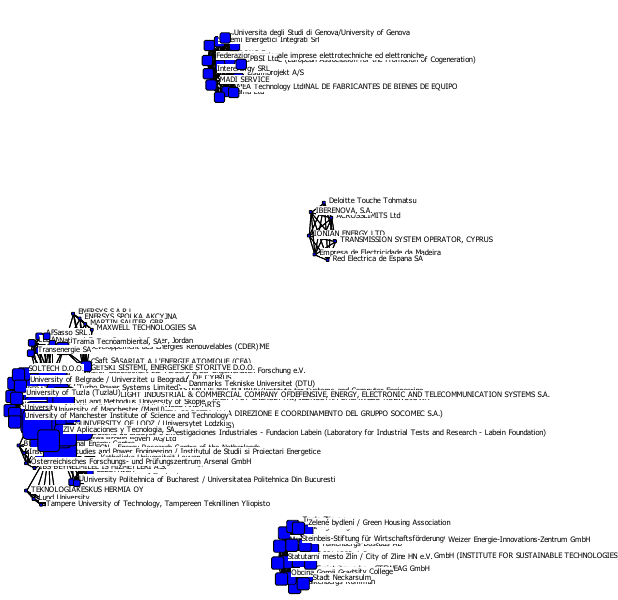
Figure 2. FP6 Distribution Grid projects. Social network based on Freeman degree centrality, four